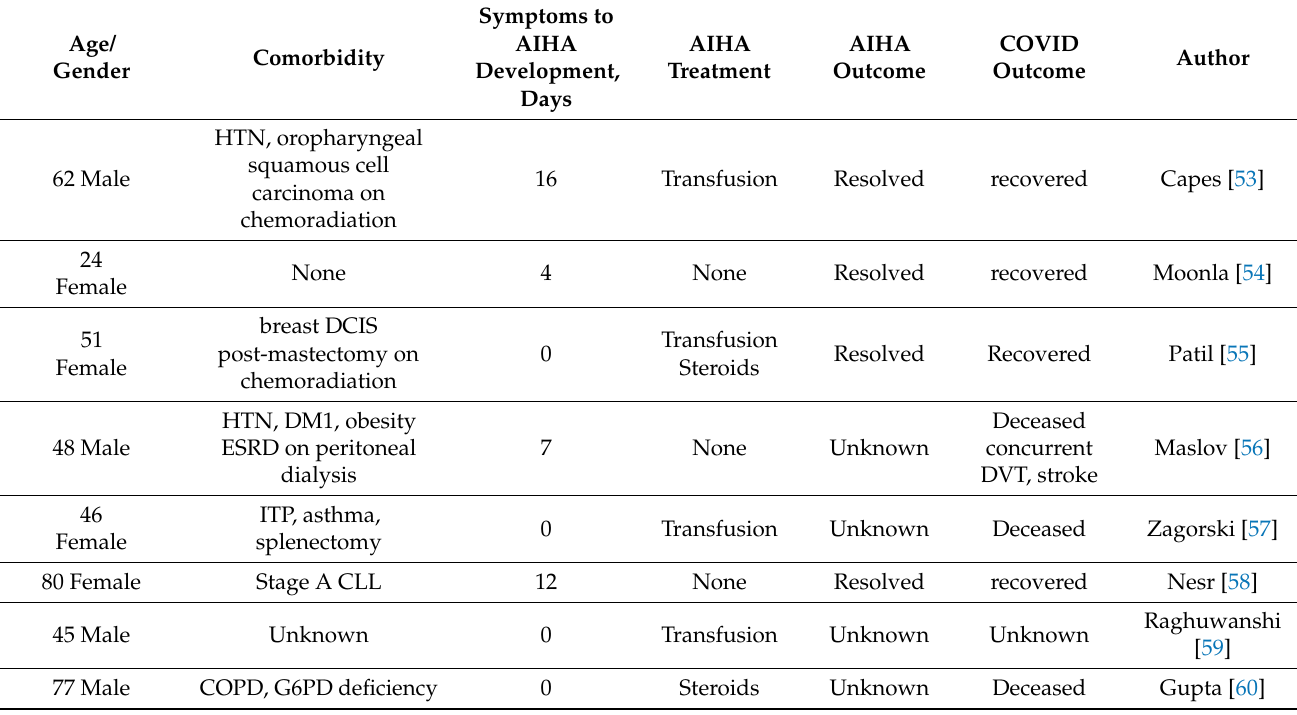
Table 2. CAS associated with SARS-CoV-2